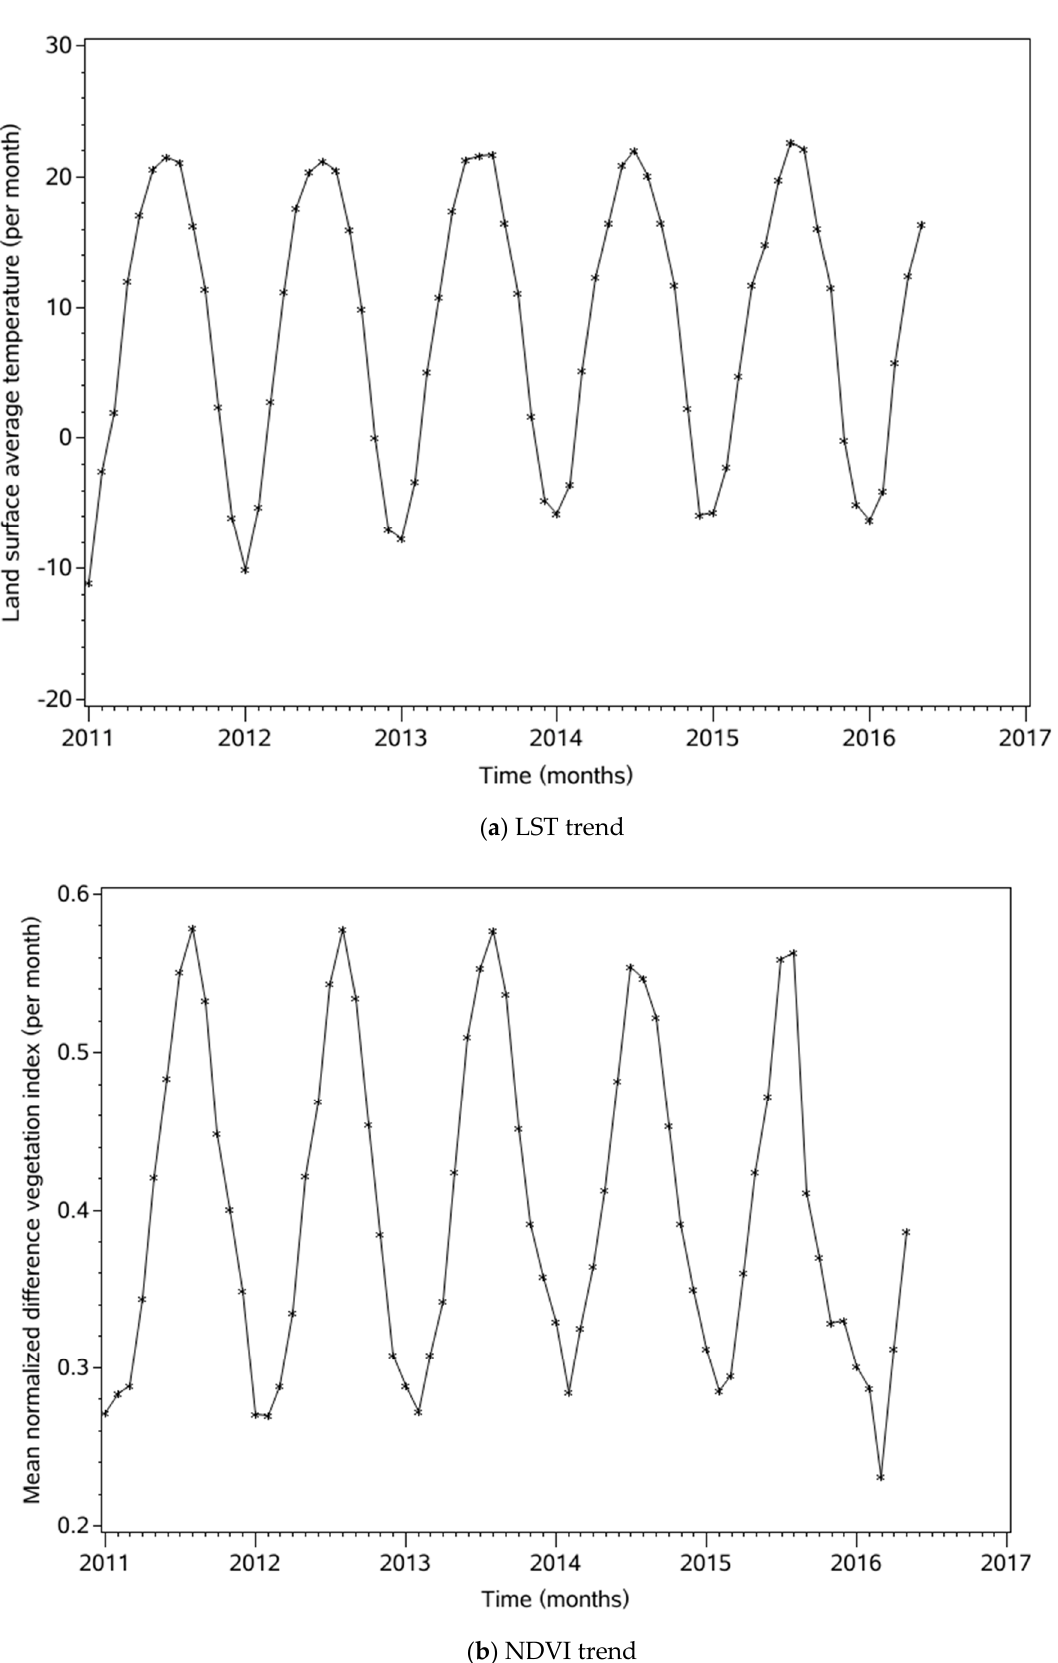
Figure 2. Trends of input variables, ( a ) LST trend, ( b ) NDVI trend.